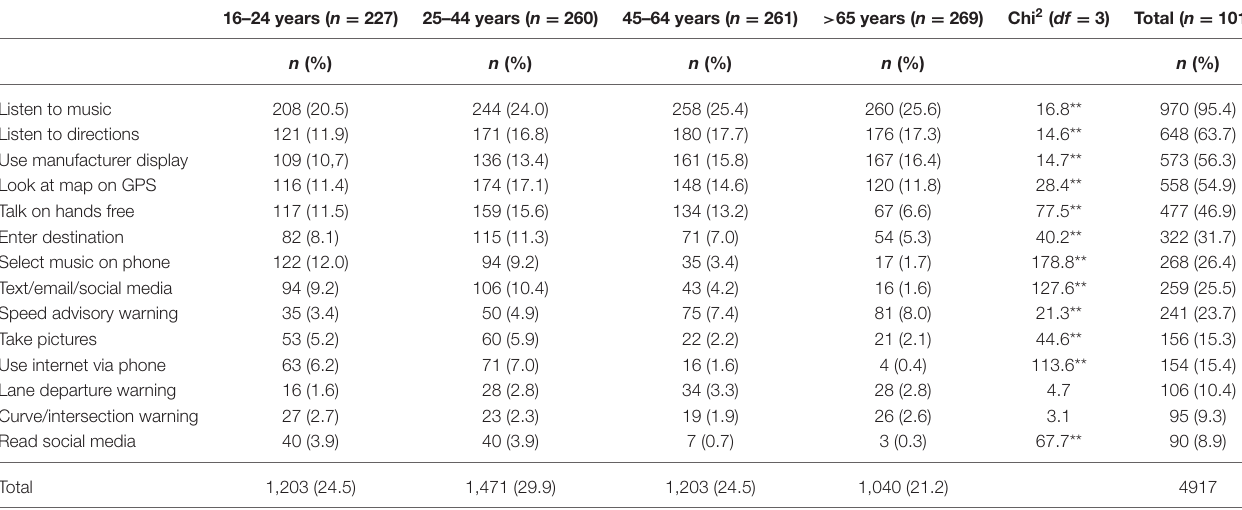
TABLE 3 | The number and percentage of the total sample engaging in each IVIS behavior or event while driving for each age